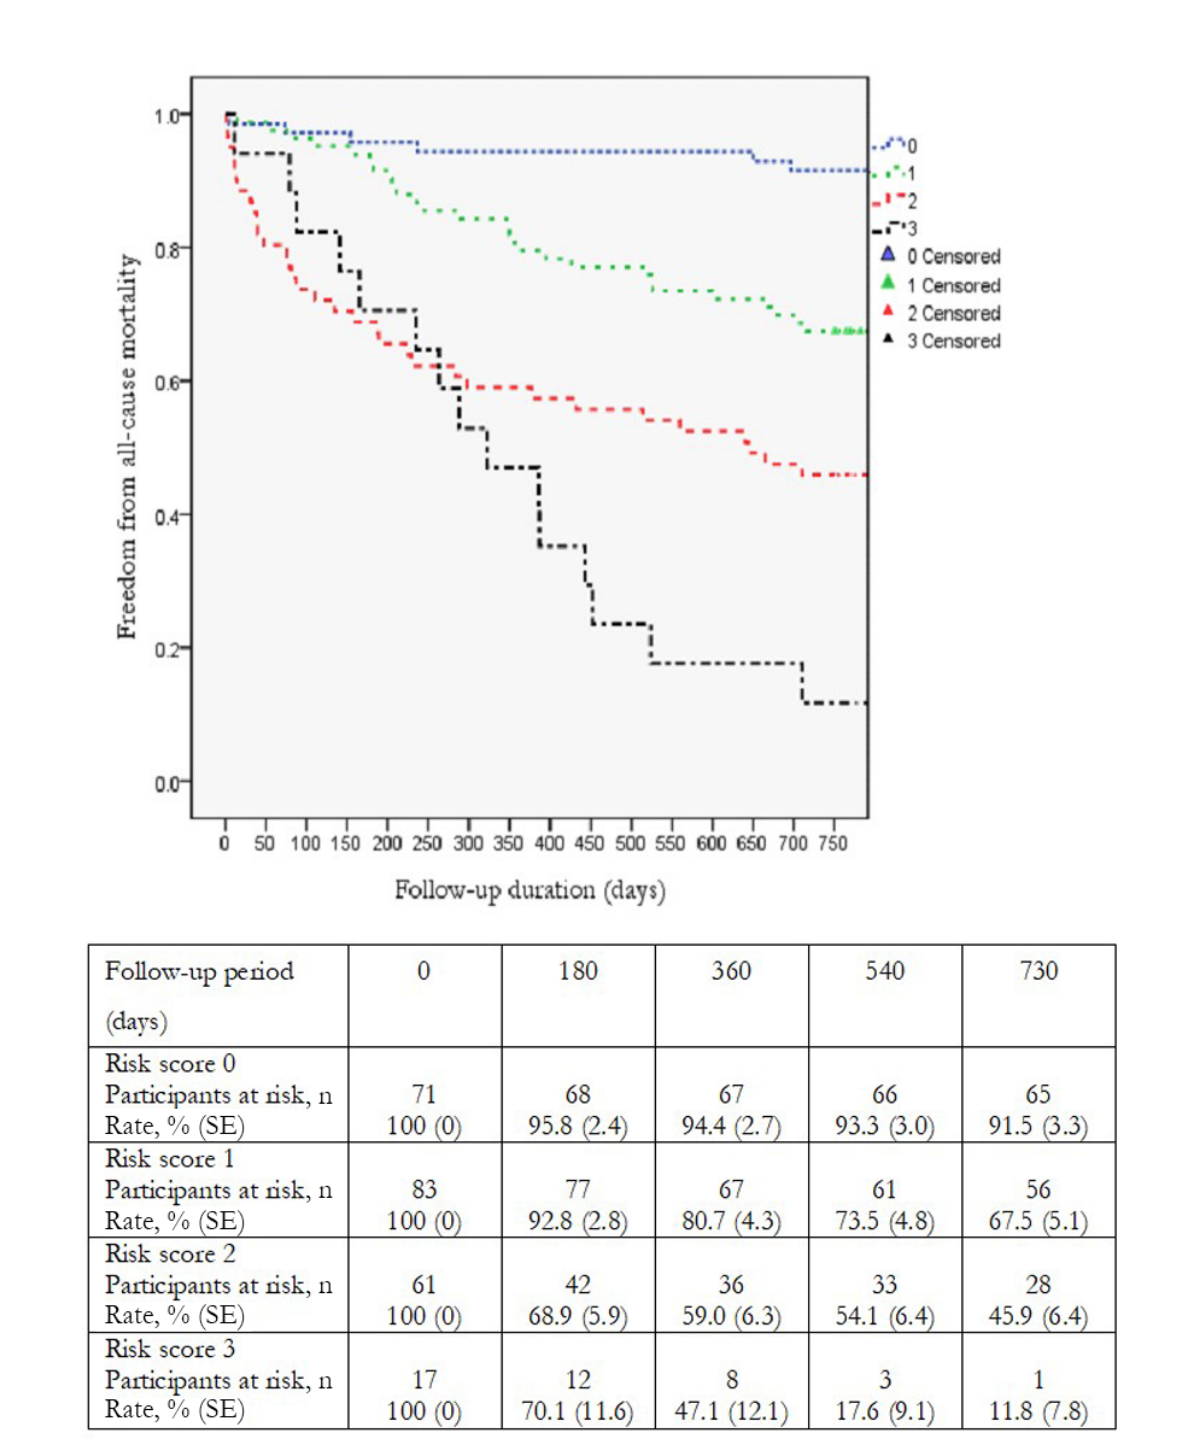
Figure 5. Kaplan-Meier analysis of 2-year survival in model